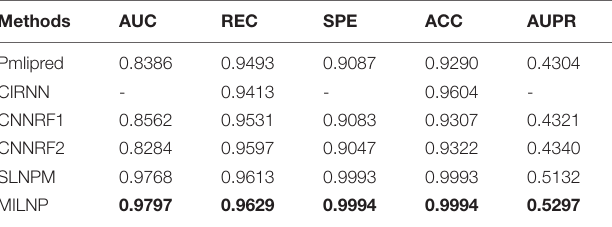
TABLE 4 | Performances of different